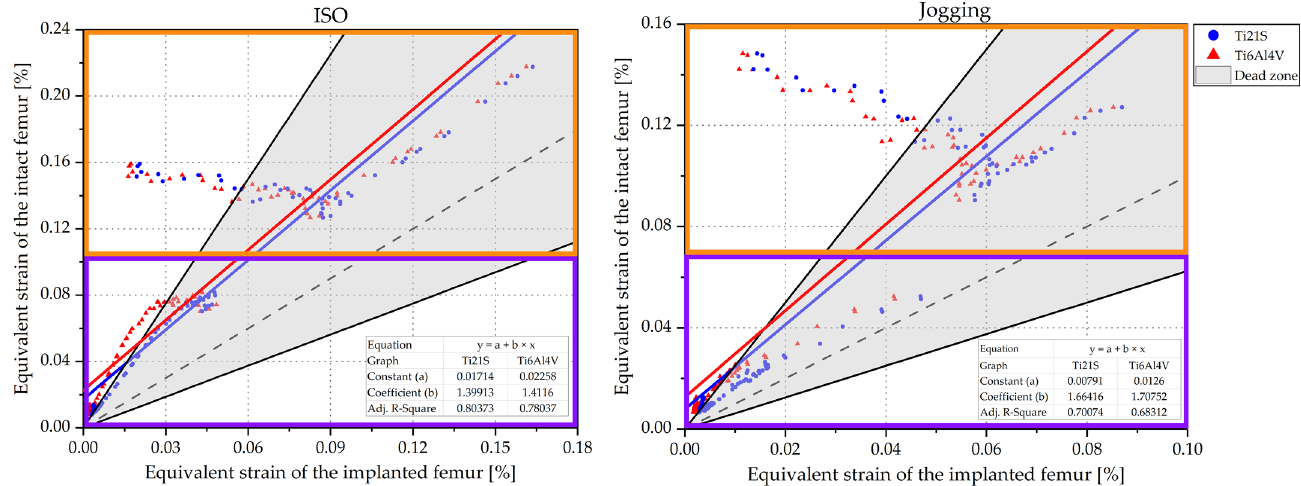
Figure 14. Regression graph of GC1 under ISO and jogging